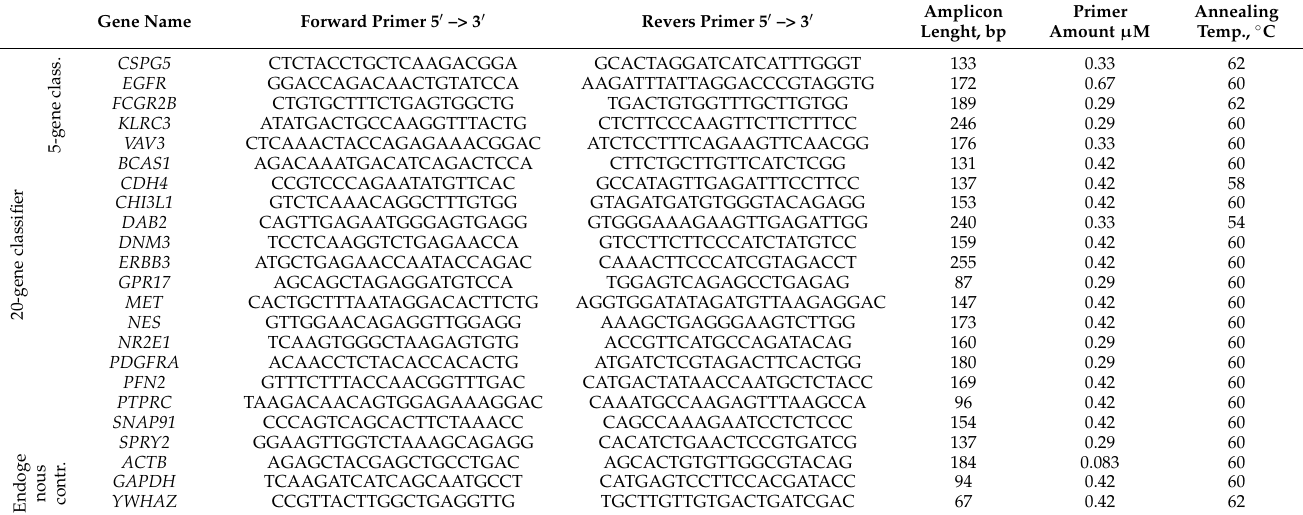
Table 2. Primer sequences and qPCR